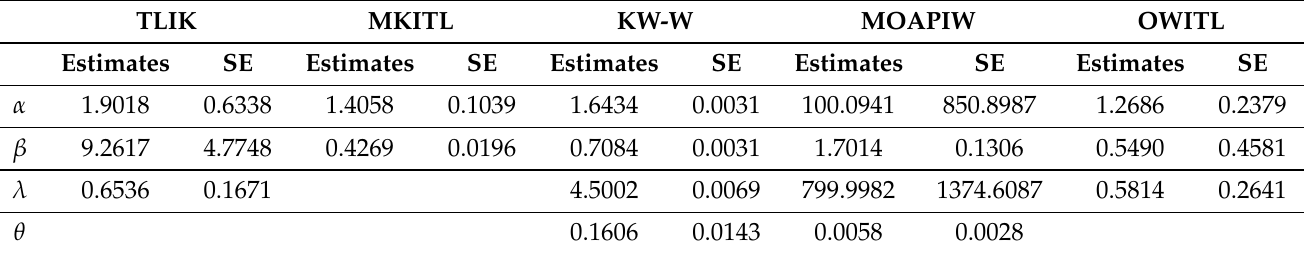
Table 6. MLE with SE for an alternative model of TIIHLW.